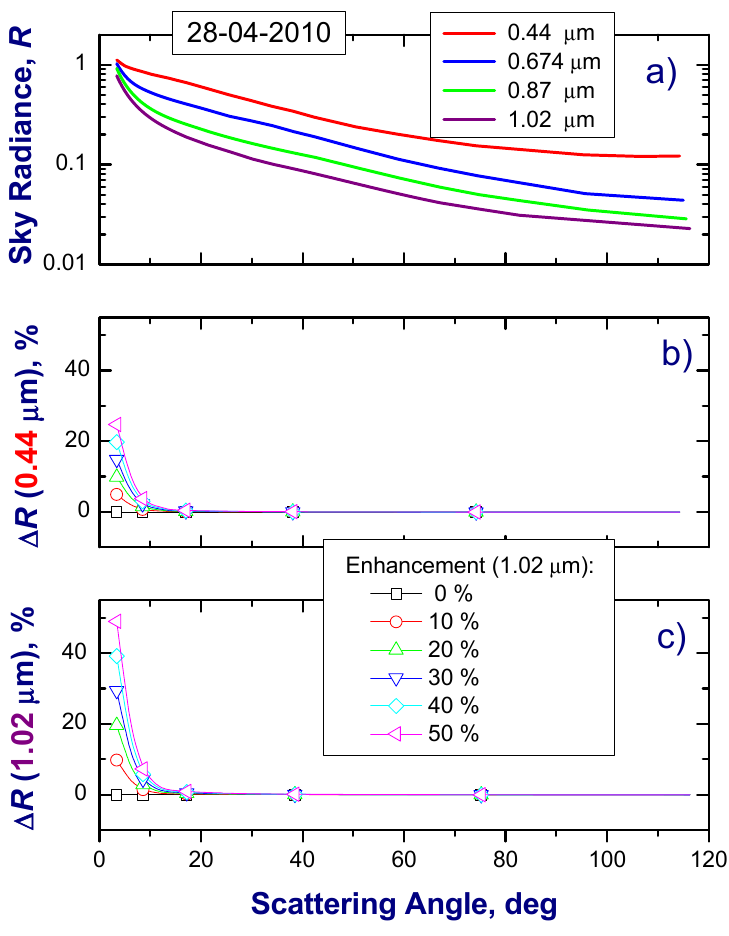
Figure 4. Example of the observed sky radiance ( R ) at four wavelengths ( a ) and the relative difference ( Δ R ) between the observed radiance and constructed artificial radiance ( b , c ) as a function of scattering angle. These differences are obtained for a given range of the spectrally dependent enhancement: from 0 to 25% at 0.44 μ m (b) and from 0 to 50% at 1.02 μ m (c) wavelengths, respectively. The conversion of the constructed radiances gives the retrieved values of microphysical (Figures 5 and 6) and optical (Figures 7–9)